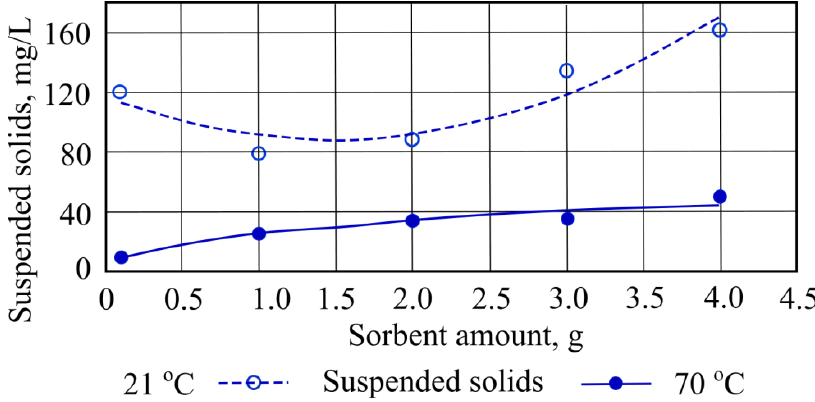
Figure 4. Suspended solids concentrations when straw sorbent is added to the wastewater.